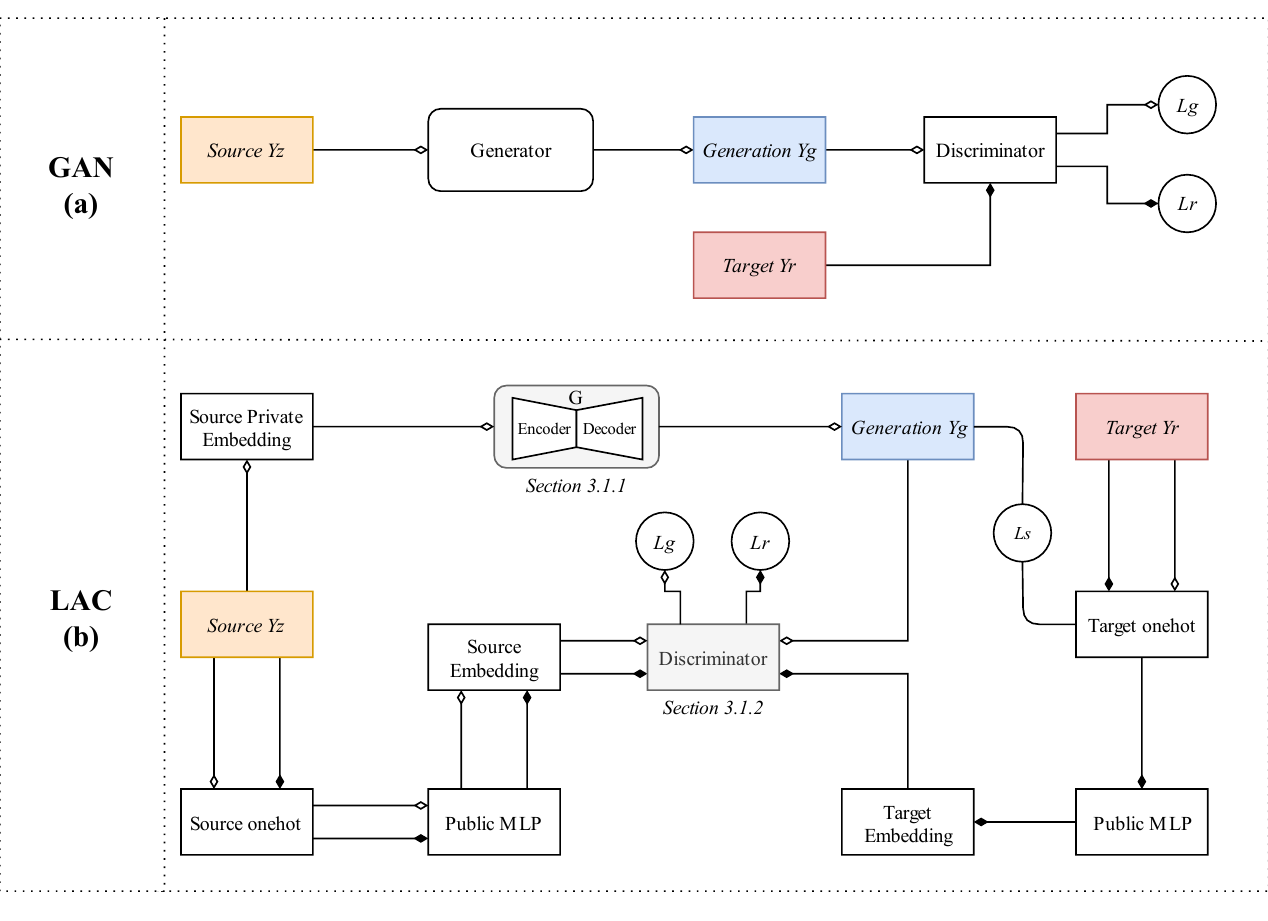
Figure 1. Comparison of the GAN and LAC models. ( a ): GAN: for image generation, the Source, Generation, and Target are randomly initialized noises, generated images, and real images, respectively. ( b ): LAC: the Source, Generation, and Target are the source language, generated translation, and human translation, respectively. Lg , Lr are the adversarial losses, Ls is the translation loss. Batches run along the White ( ♦ ) and Black ( (cid:7) ) routes in